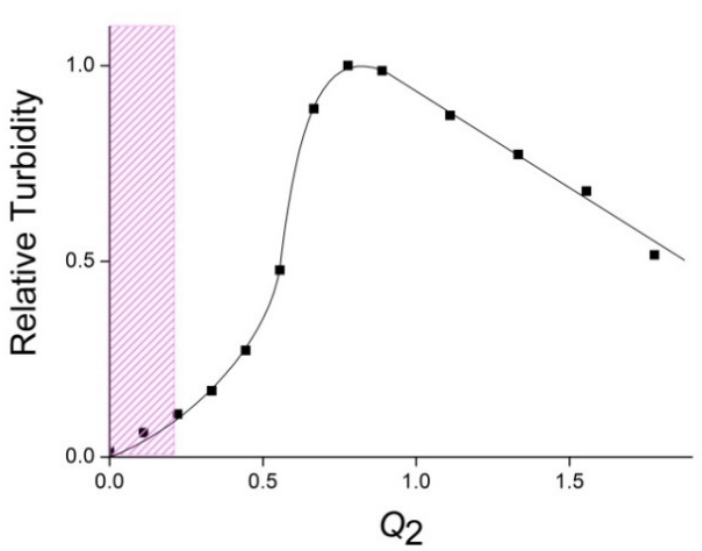
Figure 2. Relative turbidity of IPEC solutions at λ = 500 nm vs. Q 2 = [QHECE]/[ALG]. [ALG] = 10 –3 M; 10 –2 M phosphate buffer of pH 7. The cross-hatched region represents water-soluble IPECs. IPEC formation is accompanied by mutual neutralization of polyelectrolyte charges that results in a decrease of the size of macromolecular coils [41] and a progressive lower- ing of the viscosity of solutions [42]. However, contrary to expectations, the “viscosity vs. Q 1 = [ALG]/[QHECE]” plot for the cationic IPECs in the buffer solution of pH 7 is de- scribed by a curve with a pronounced maximum at Q 1 = 0.2 (Figure 3, curve 1), but not a smooth falling curve. The increase in viscosity can be explained as follows. The viscosity of an initial 1 wt% solution of QHECE is rather high, i.e., 25 cSt, which obviously reflects